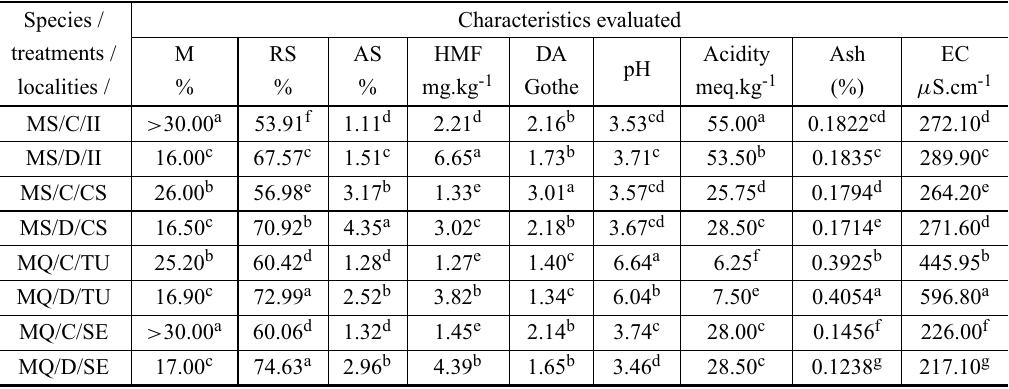
Mean values for physicochemical parameters of Melipona scutellaris (MS) and Melipona quadrifasciata (MQ) honey, either fresh or submitted to a dehumidification process. Characteristics